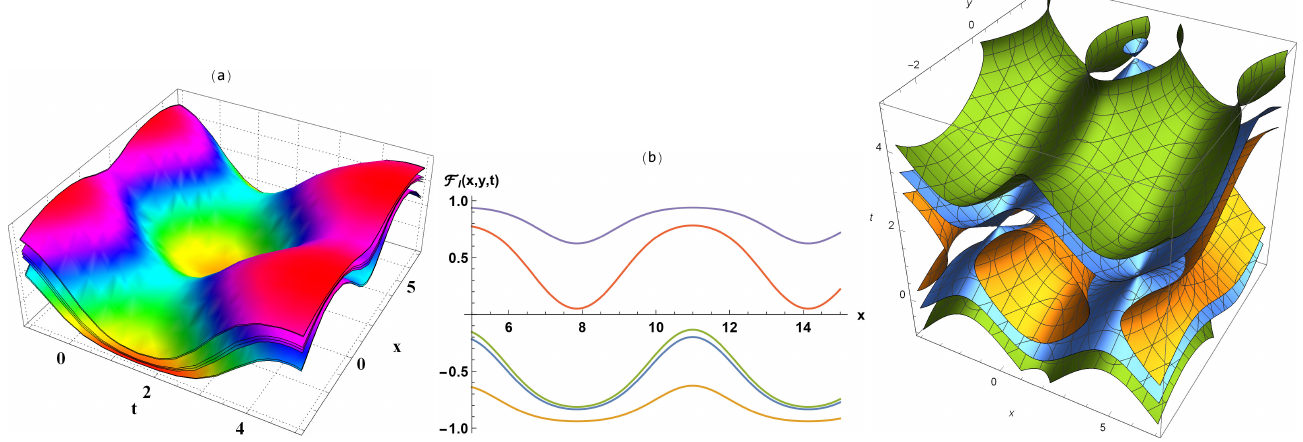
Figure 3. Computational wave solutions of Equation (28) in 3D ( a ), 2D ( b ), and contour ( c )